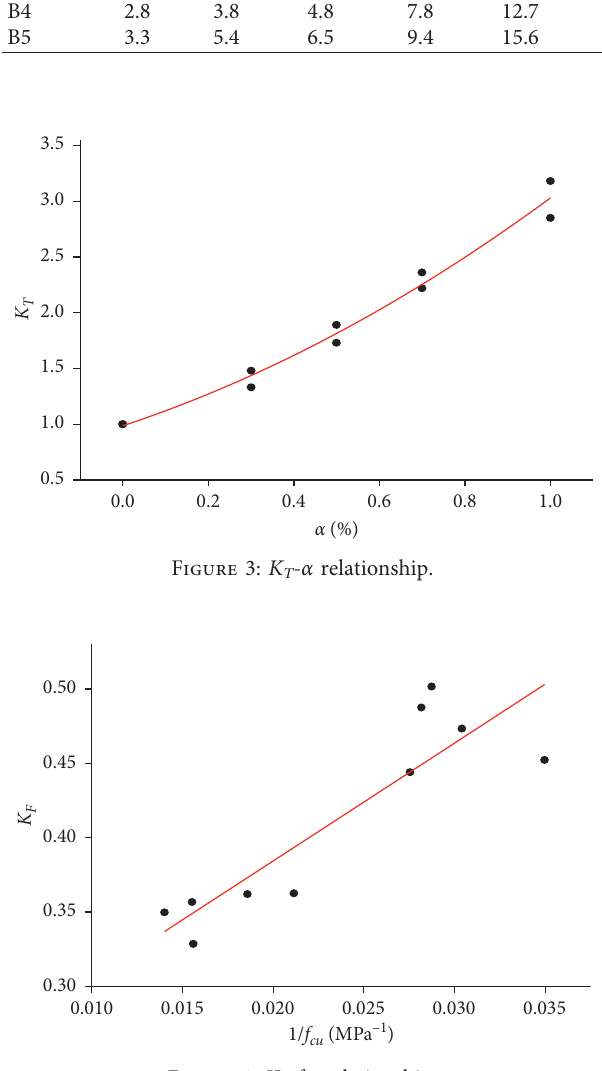
Figure 4: K F - f cu